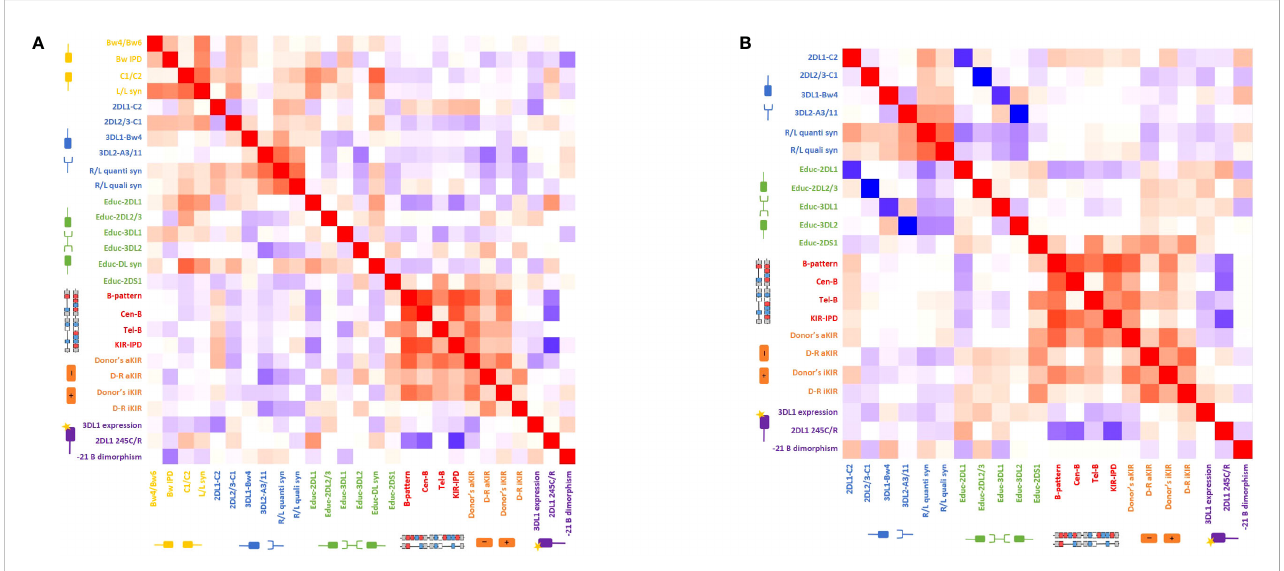
FIGURE 5 Heatmap of the Spearman ’ s correlation coef fi cients re fl ecting the strength of the association between the different biological models (A) for the haploidentical cohort and (B) for the genoidentical cohort. Red squares represent a positive correlation between two different models whereas blue squares represent a negative correlation between two different models. See also Supplementary Tables 1, 2.